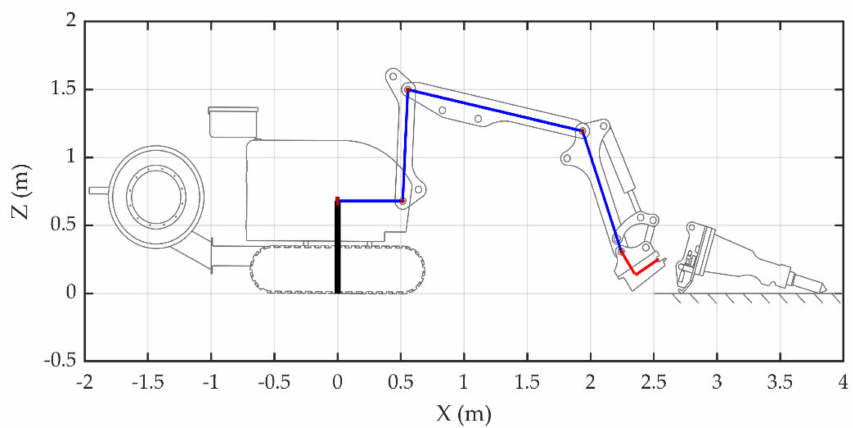
Figure 6. Preparation of the demolition robot attachment changing